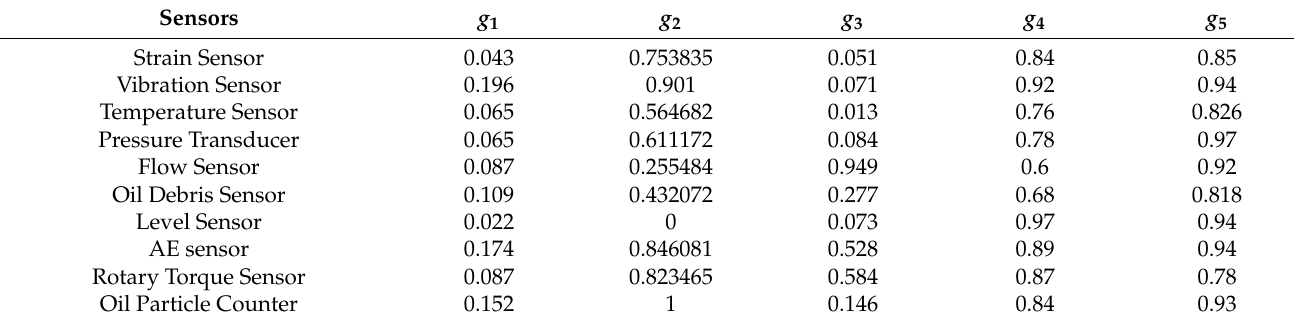
Figure 2. Net outranking flow for each alternative. Table 7. Net outranking flow for each criterion.